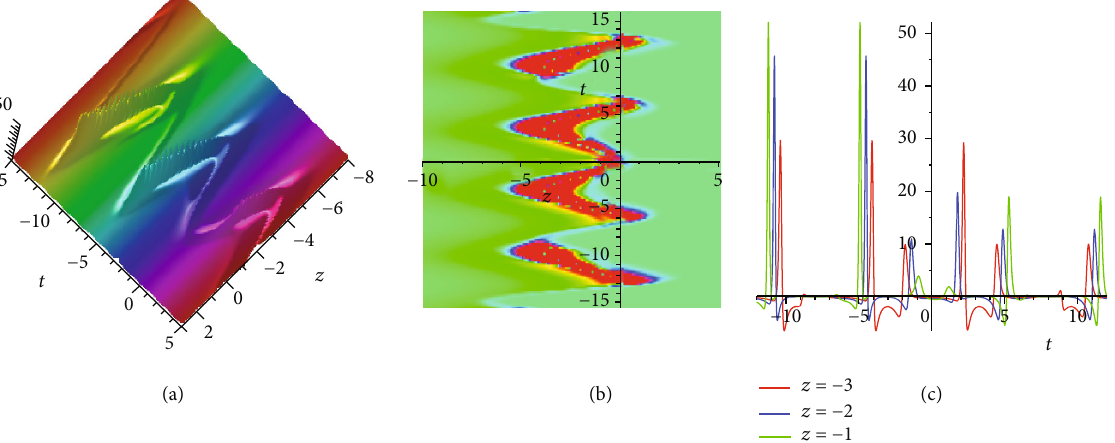
Figure 4: Plots of interaction lump with two solitons (30).